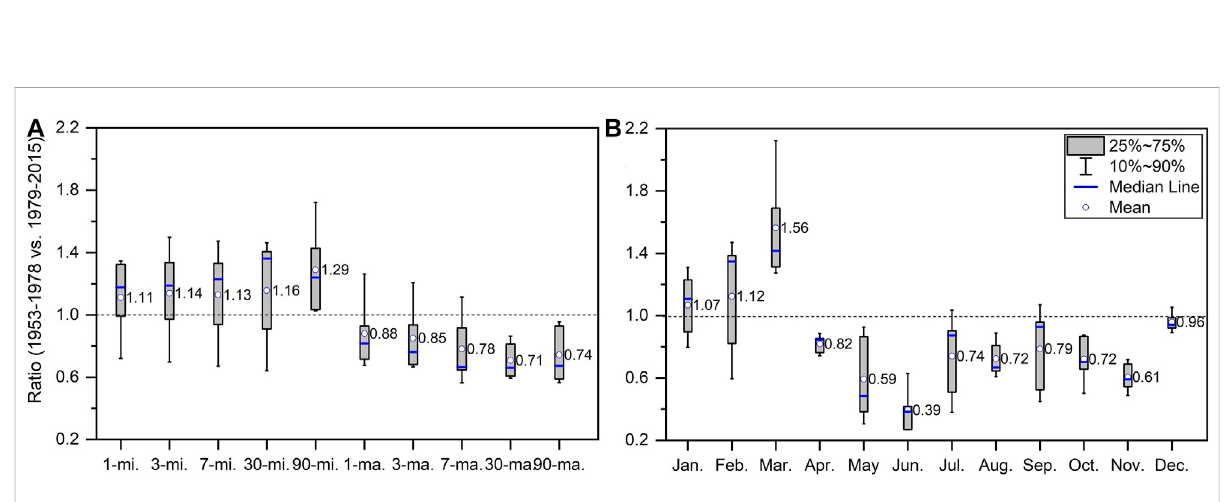
FIGURE 10 Variation of RVA for the LRB before and after 1979, in extreme pattern (1-mi. represents 1-day minimum, and 1-ma. indicates 1-day maximum value) (A) , and in monthly pattern (B)